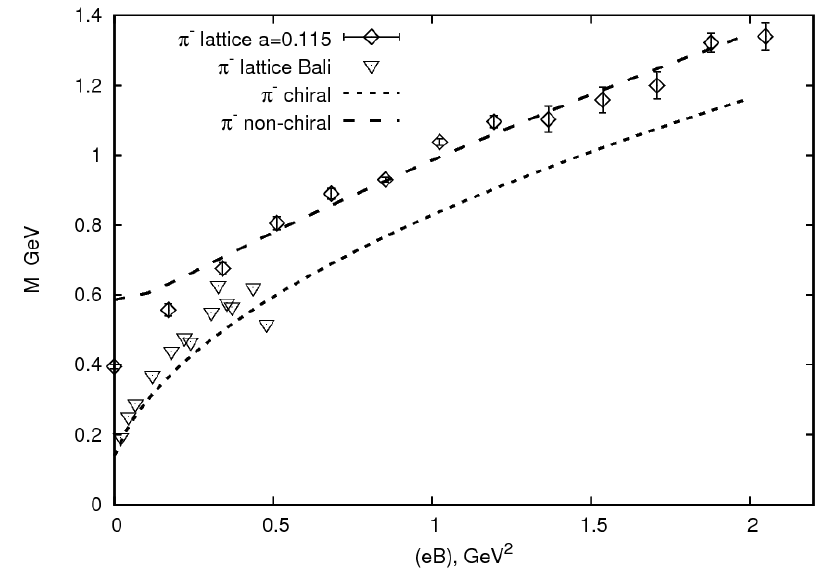
Figure 3 . Mass evolution of the chiral (solid line) and nonchiral (dashed line) (cid:25) (cid:0) meson in MF in comparison with the lattice data: triangles [42] and quadrangles with lattice spacing a = 0 : 115 ; fm (present